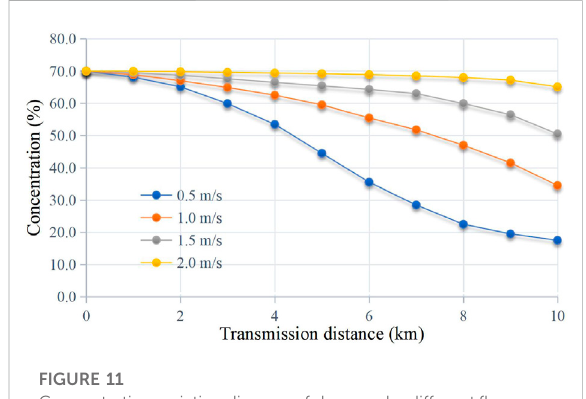
FIGURE 11 Concentrationvariationdiagramofslurryunderdifferent fl ow velocities.